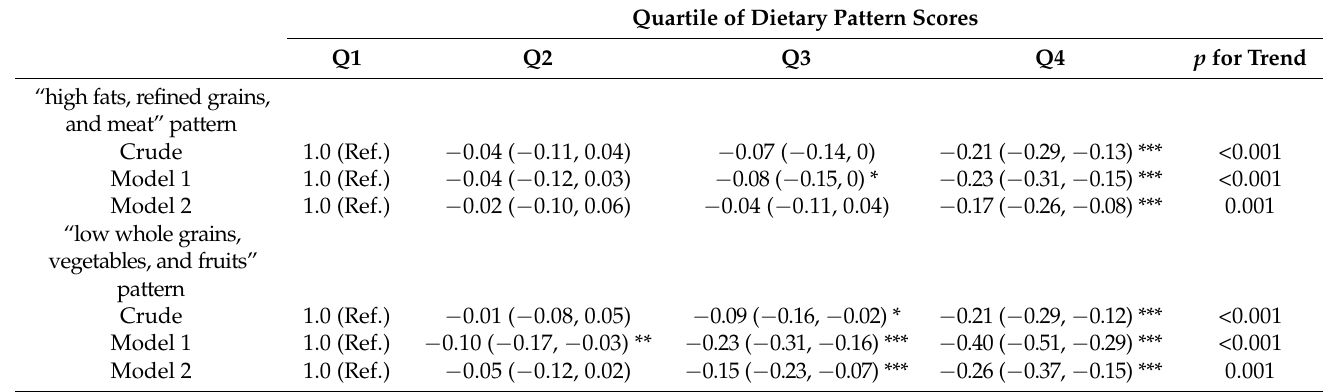
Table 3. Coefficients of sleep duration and corresponding 95% CIs according to quartiles of dietary pattern scores from partial least squares 1